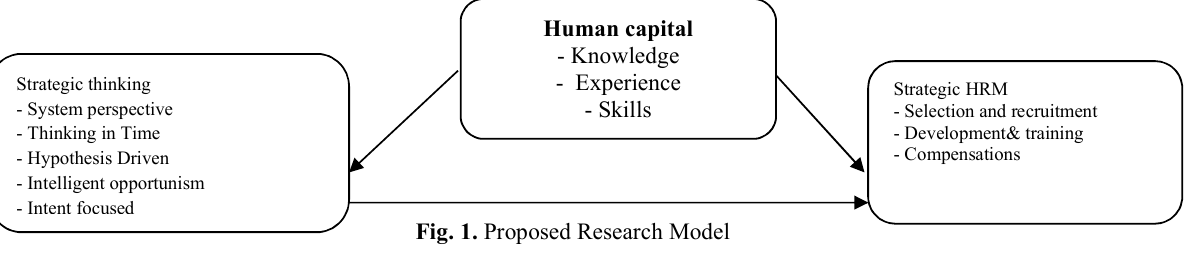
Fig. 1. Proposed Research